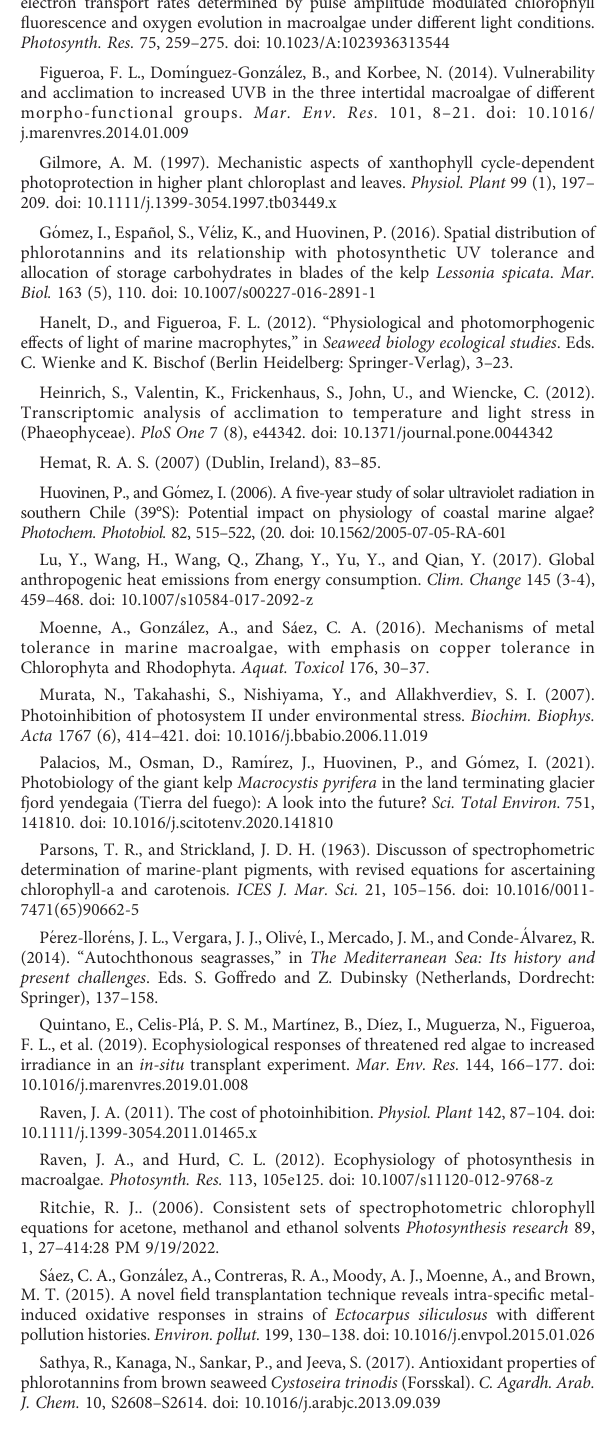
by different pulse amplitude modulated fl uorometers and oxygen evolution. J. Exp. Bot. 72, 491 – 509. doi: 10.1093/jxb/eraa473 Figueroa, F. L., Celis-Pla ́ , P. S. M., Mart ı ́ nez, B., Korbee, N., Trilla, A., and Arenas, F. (2019). Yield losses and electron transport rate as indicators of thermal stress in Fucus serratus (Ochrophyta). Algal. Res. 41, 101560. doi: 10.1016/ j.algal.2019.101560 Figueroa, F. L., Conde-A ́ lvarez, R., and Go ́ mez, I. (2003). Relations between electron transport rates determined by pulse amplitude modulated chlorophyll fl uorescence and oxygen evolution in macroalgae under different light conditions. Photosynth. Res. 75, 259 – 275. doi: 10.1023/A:1023936313544 Figueroa, F. L., Dom ı ́ nguez-Gonza ́ lez, B., and Korbee, N. (2014). Vulnerability and acclimation to increased UVB in the three intertidal macroalgae of